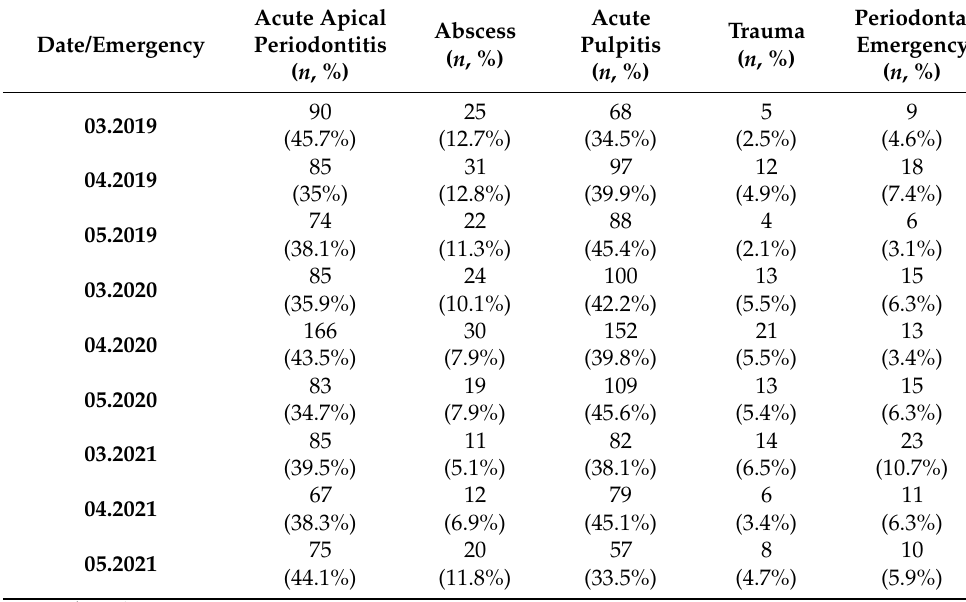
Table 2. Distribution according to type of emergency.